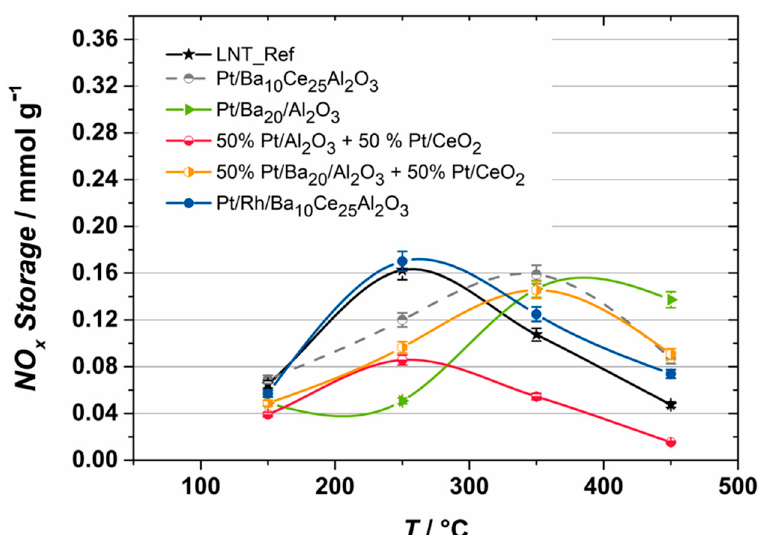
Figure 4. Temperature-dependent NO X storage capacity of different physical catalyst mixtures, different PGM loaded infiltrations composites and the reference LNT.